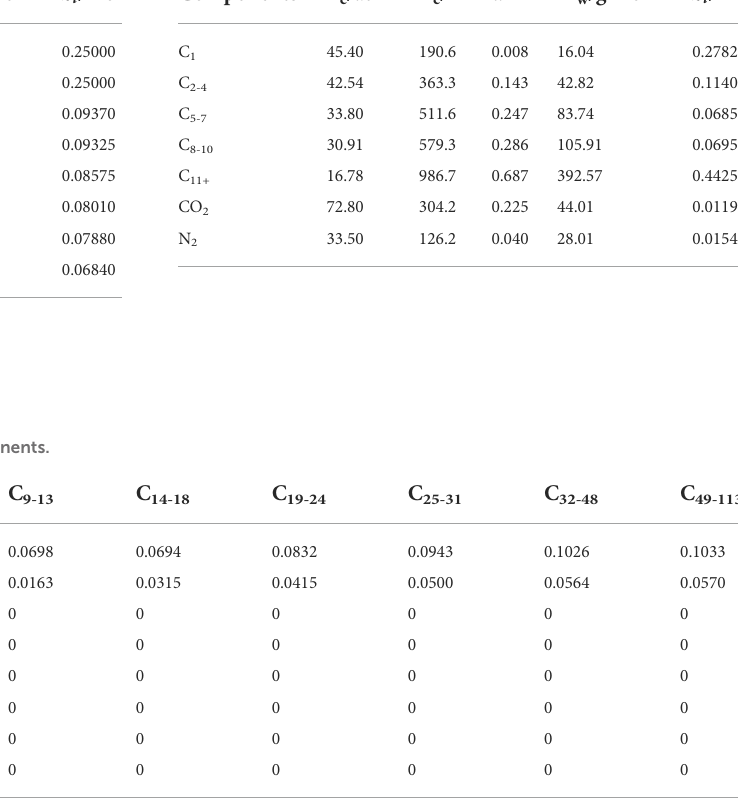
TABLE 9 The physical property parameters of CO 2 /N 2 /hydrocarbons systems of the oil sample in Tahe oil fi eld.